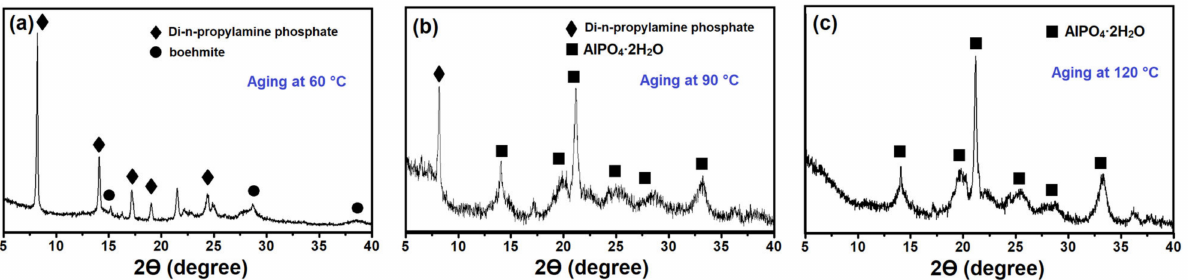
Figure 4. X-ray diffraction patterns of silicoaluminophosphate gels subjected to aging at different temperatures: ( a ) Sample SAPO-PB-1.0(60); ( b ) Sample-SAPO-PB-1.0(90); ( c ) Sample-SAPO-PB- 1.0(120).